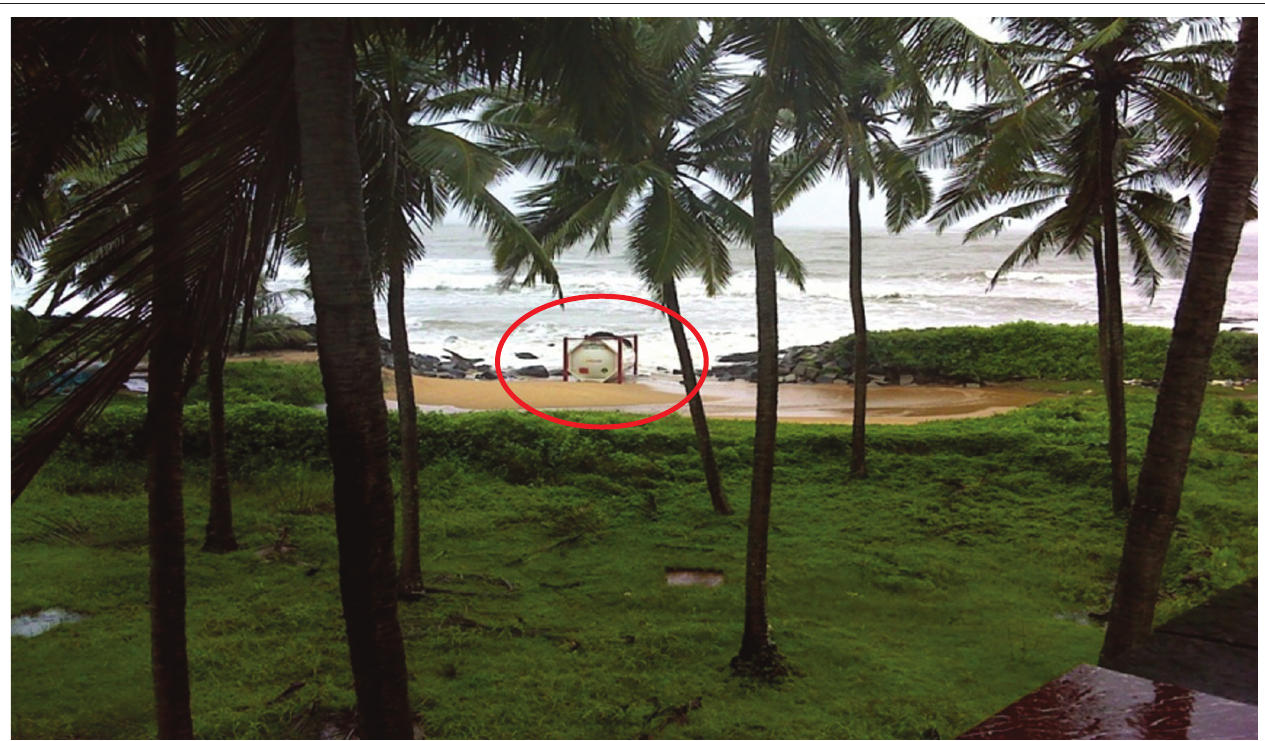
FIGURE 4: Container at Kottikulam beach found in between the damaged sea wall.